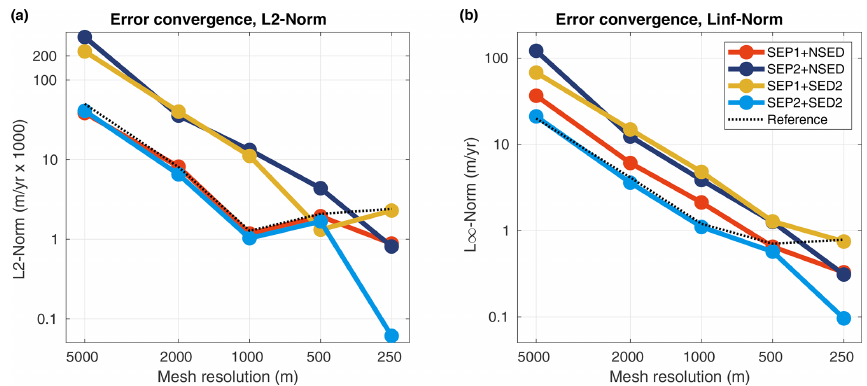
Figure 3. Error convergence of the ice speed for the diagnostic analysis in L 2 norm (a) and L ∞ norm (b) . All sets of sub-element parameter- izations are shown: SEP1 + NSED, SEP2 + NSED, SEP1 + SED2, and SEP2 + SED2. The error convergence from structured conforming- mesh-based models is also shown (reference, dotted line).